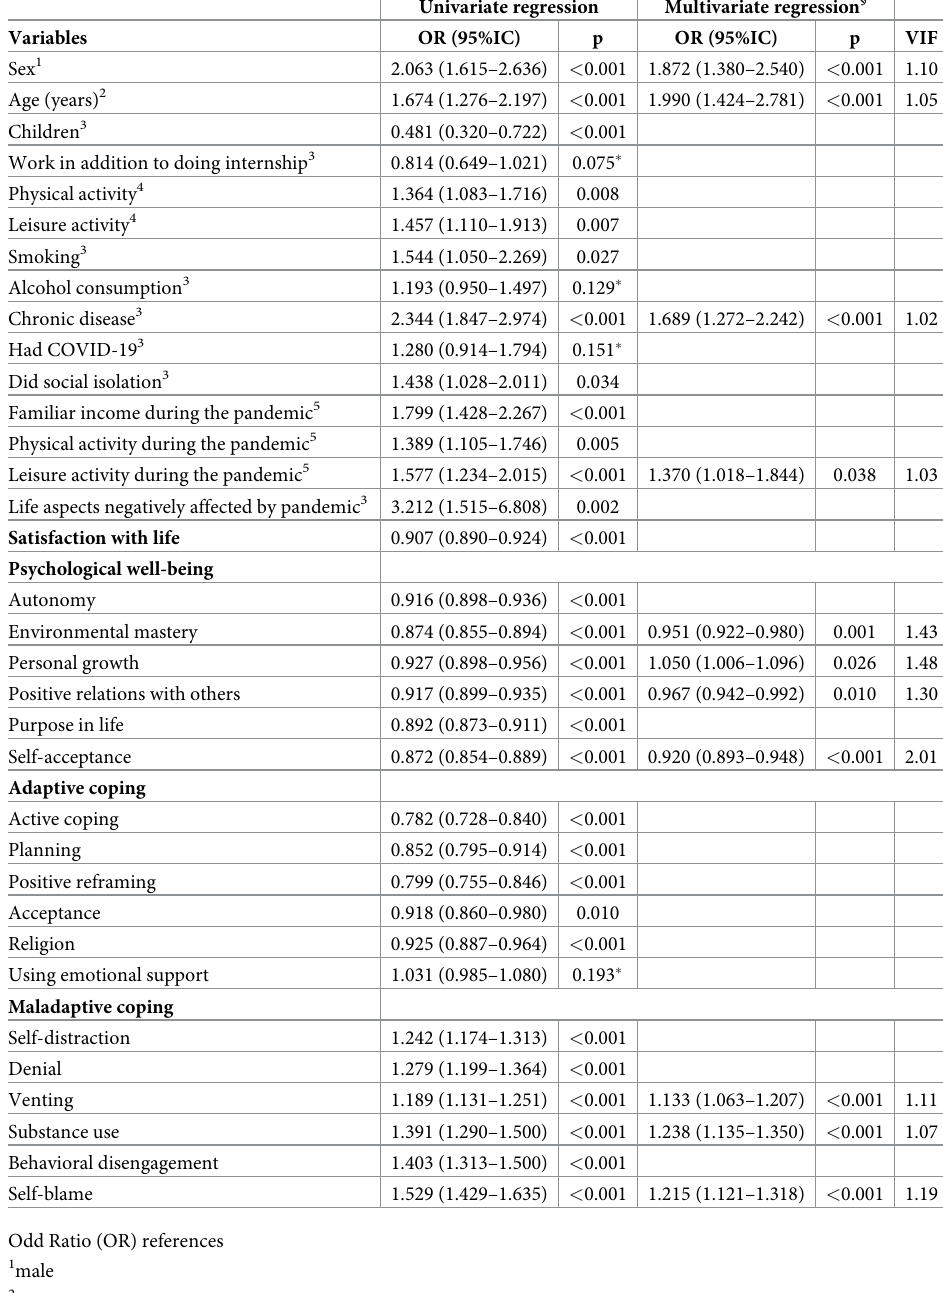
Table 7. Univariate and multivariate logistic regression of independent variables in relation to symptoms of stress in undergraduate students, Parana, Brazil,